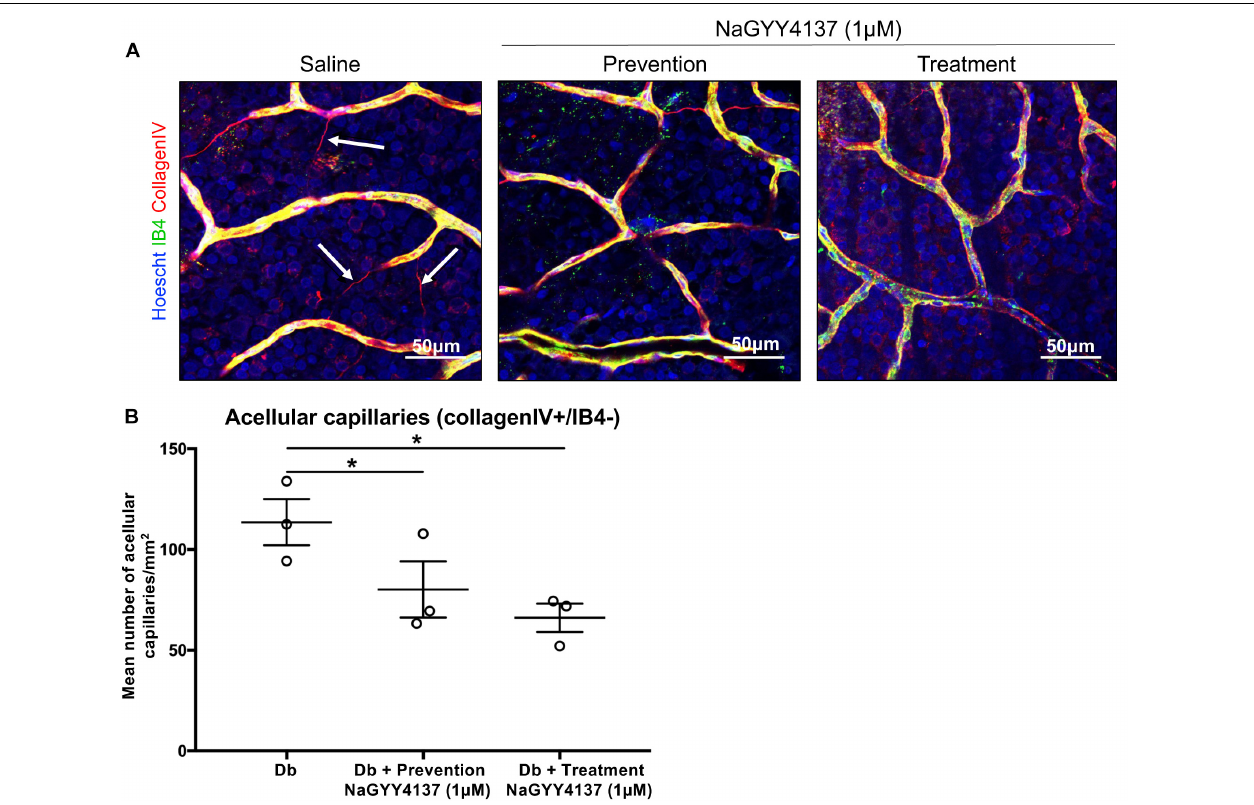
FIGURE 6 | NaGYY4137 protected against diabetes-induced increase in acellular capillaries. Norway Brown rats were given a single dose of streptozotocin (50 mg/kg) to induce Type I diabetes. Rats were treated with an intraocular injection of either saline or 1 µ mol/L H 2 S donor NaGYY4137 at day 0 (prevention) or day 6 (treatment). (A) Rats were enucleated at day 7 and whole retinae were mounted and stained with Hoescht, IB4, and collagen IV. The tissue was imaged using 20 × lens. The number of capillaries positively stained for collagen IV but lacking IB4 (white arrows) were counted in three areas of the retina. (B) Acellular capillaries are expressed per mm 2 . Error bars represent standard errors of the mean. Statistical analysis was performed using a one-way analysis of variance corrected for false discovery rate. * p ≤